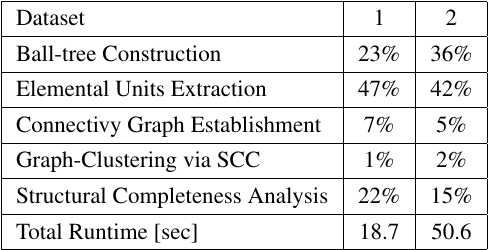
Table 2: Segmentation performance evaluation